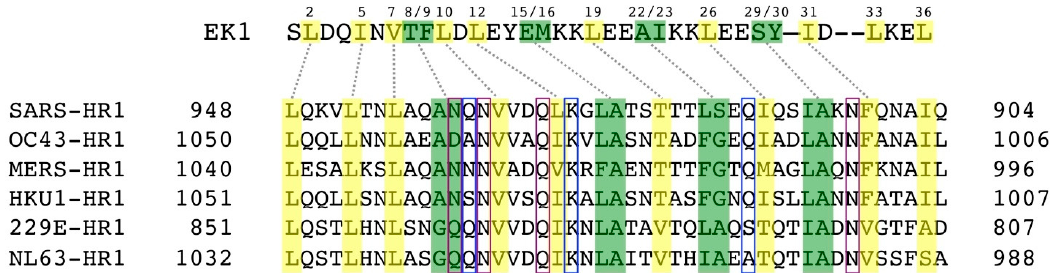
Figure 7. The interactions of the broad-spectrum peptide inhibitor EK1 with HR1 residues of di ff erent HCoVs. EK1 and HR1 residues connected with dashed gray lines locate to the same layers on the 3HR1 triple helix. Burying EK1 residues are highlighted in yellow, and ridge-packing EK1 residues are highlighted in green. HR1 residues that mediate assembly of the 3HR1 cores are highlighted in yellow, while those involved in ridge packing are highlighted in green. HR1 residues forming conserved side chain-to-side chain and side chain-to-main chain hydrophilic interactions with EK1 residues are indicated with boxes colored blue and purple, respectively. Adapted from ref.